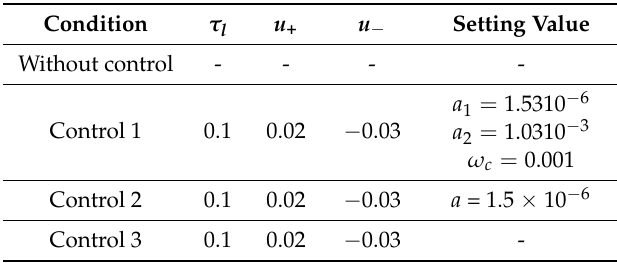
Table 2. Condition of numerical